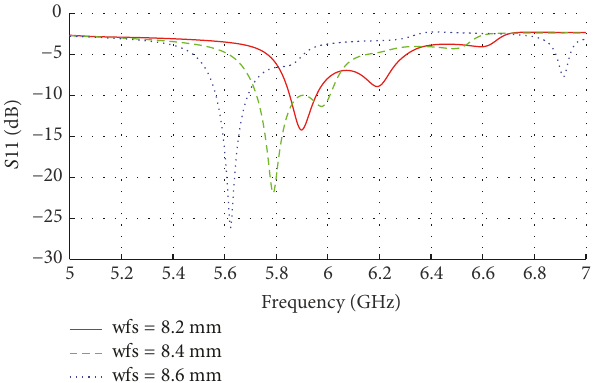
Figure 11: The optimization of distance between the